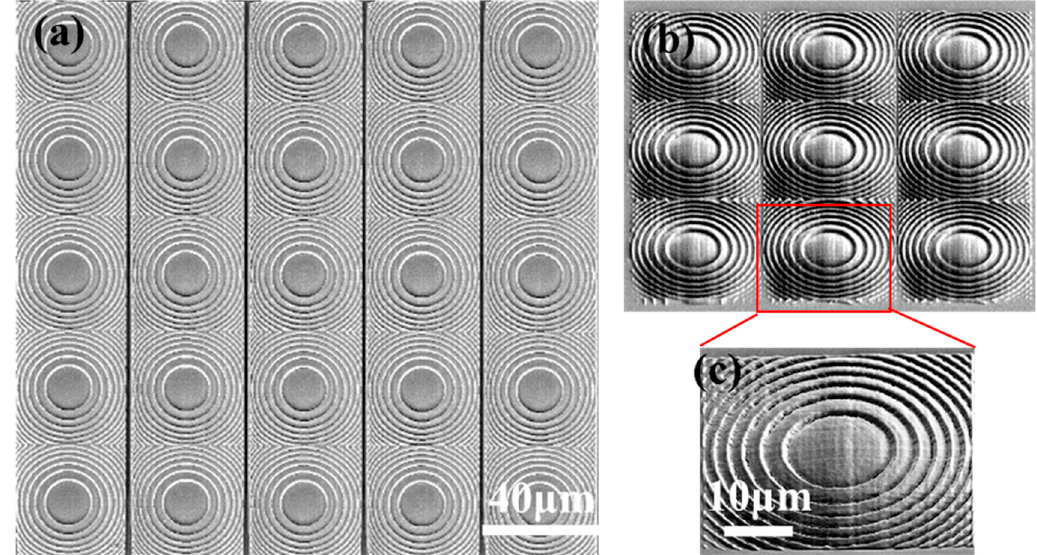
Figure 3. Continuous surface Fresnel lens array fabricated by femtosecond laser TPP via 3D focal field engineering. ( a ) The top view scanning electron microscopic (SEM) image of a 5 × 5 lens array; ( b ) The 45 ◦ side view SEM image of a 3 × 3 lens array; ( c ) The magnified SEM image of a lens in the 3 ×